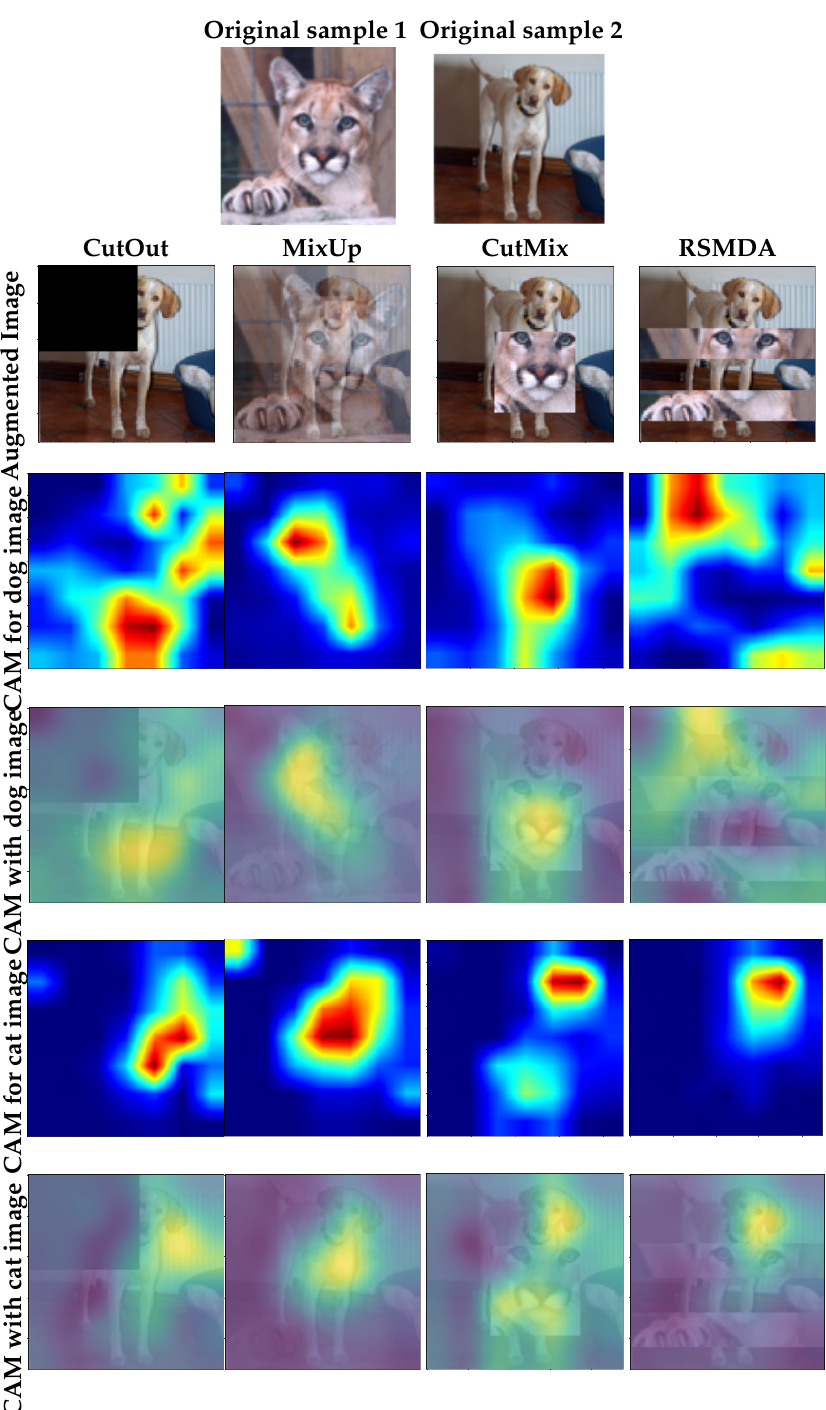
Figure 7. Data augmentation visualizations